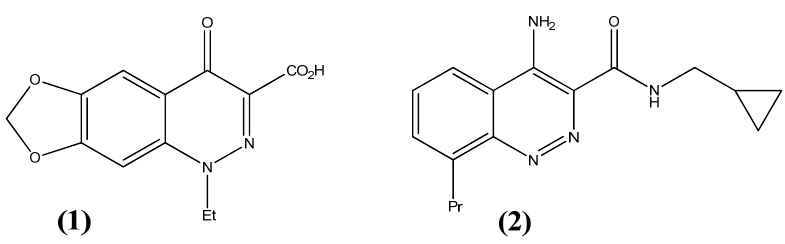
Figure 1. Cinoxacine ( 1 ) and ICI-D-7569 ( 2